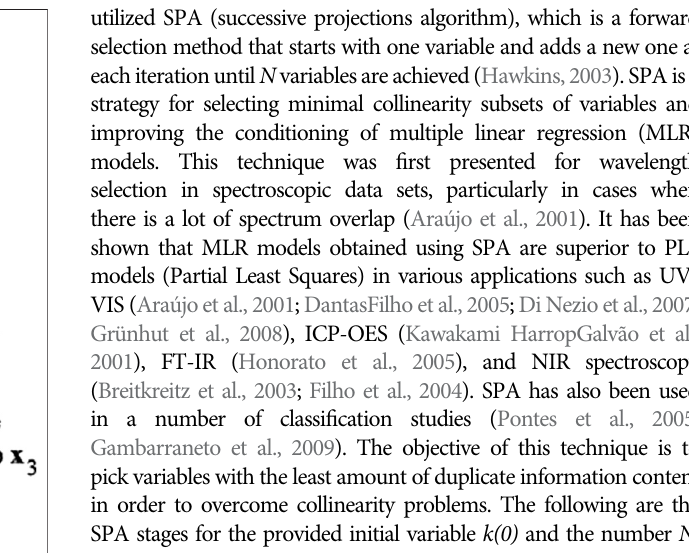
Frontiers in Chemistry |